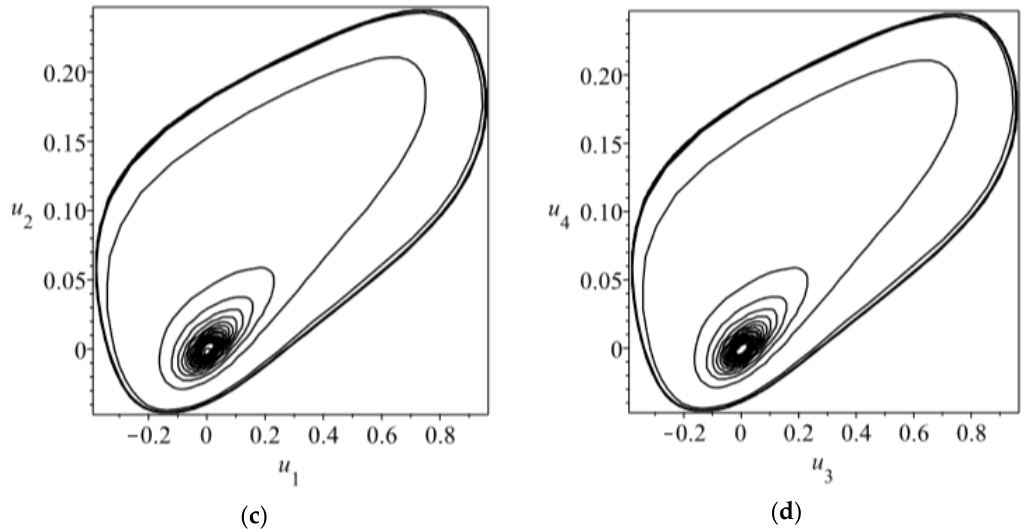
Figure 3. Synchronization errors ( a , b ) and phase diagrams ( c , d ) for Equation (12) with a = 0.1, b = 0.08, γ = 3, c = 0.16 and τ = 7. The initial conditions are chosen as u 3 ( t − τ ) = 0.02, u 4 ( t − τ ) = 0.01 for t ∈ ( − τ ,0 ] .